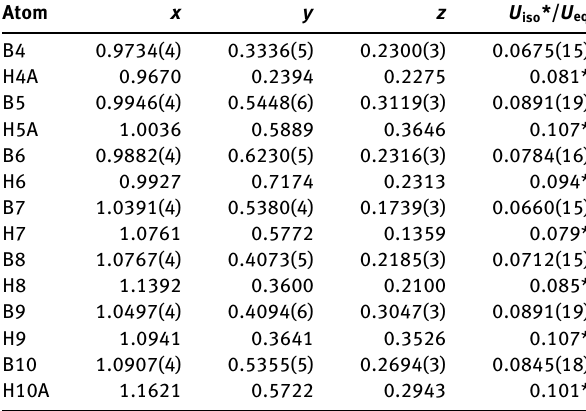
The figure depicts a perspective of the complex showing the atom numbering. The environment of the Zn atom is six coordinated, in which two positions are occupied by the two sulphur atoms, four positions are occupied by the nitrogen atoms of two 1,10-phenanthroline ligand. The bond lengths of Zn1—S1 and Zn1—S2 are 2.413 Å and 2.411 Å, respectively. The bond lengths of Zn1—N1, Zn1—N2, Zn1—N3 and Zn1—N4 are 2.253 Å, 2.233 Å, 2.235 Å and 2.223 Å,